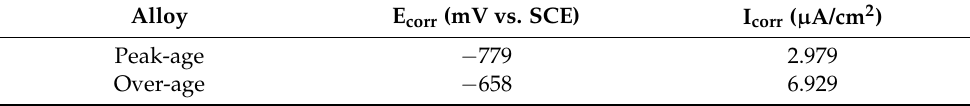
Figure 12. Typical Tafel polarization curve of the peak-age alloy and over-age alloy. Table 4. Tafel polarization parameters of the aged Al-Li alloys tested in 3.5% NaCl solution. Alloy